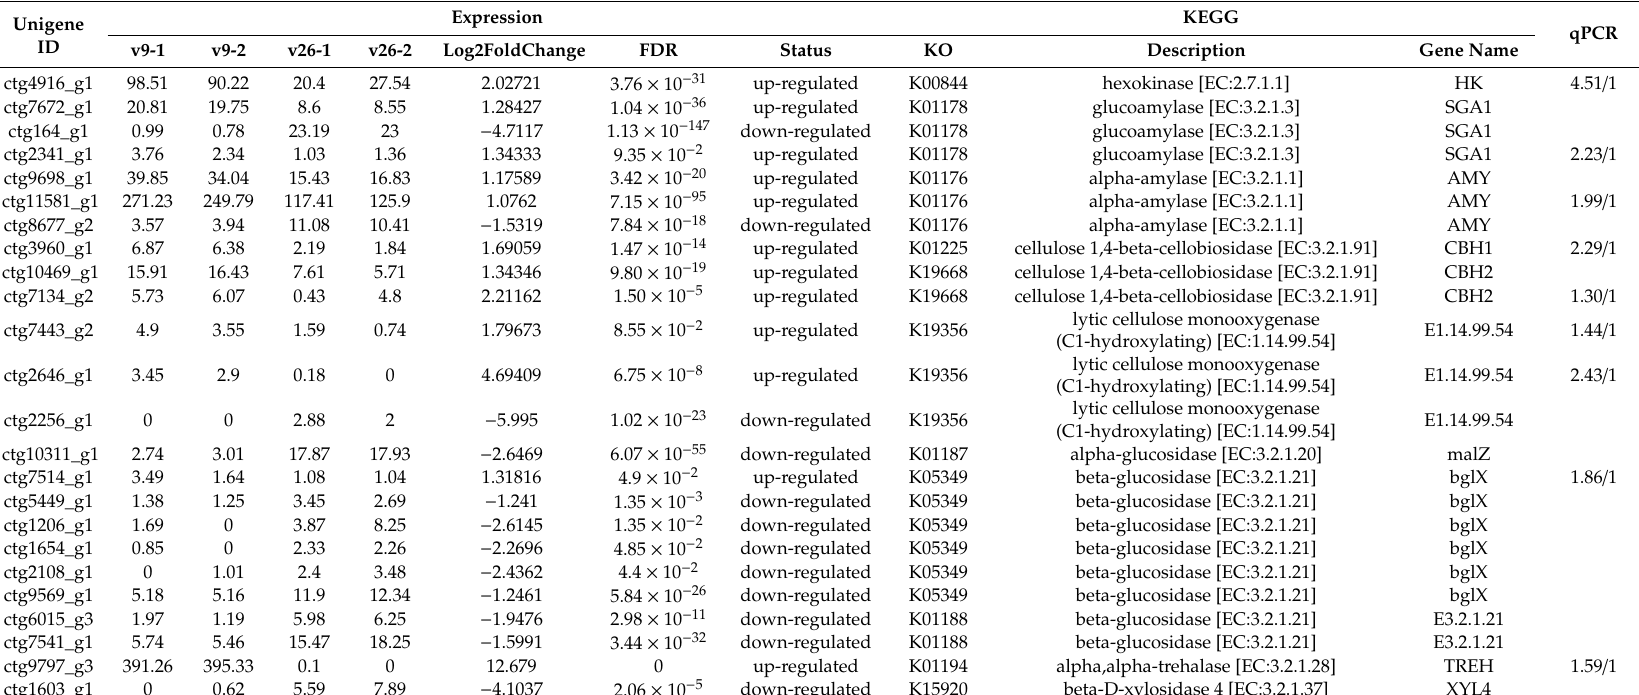
Table 2. DGEs enriched in the starch and sucrose metabolism